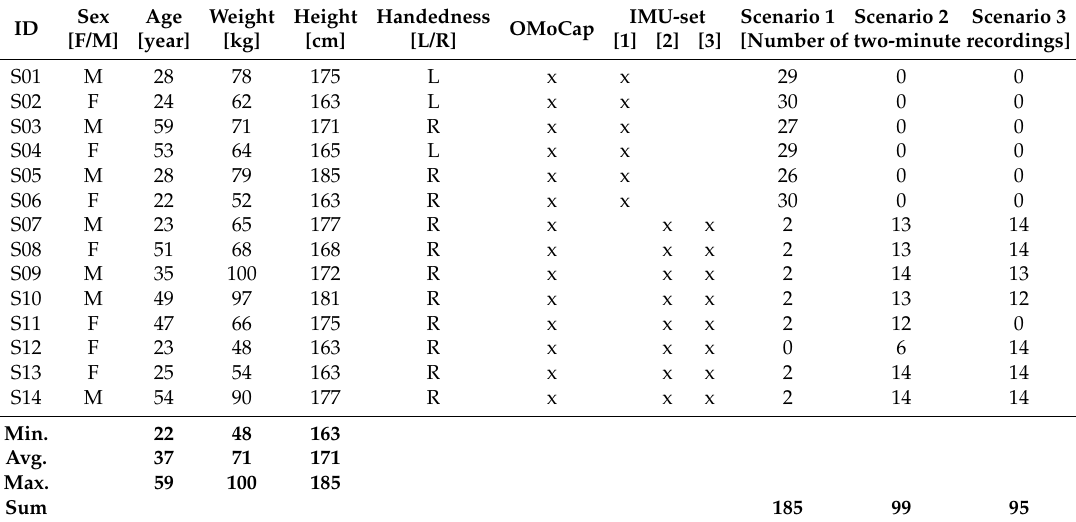
Table 1. Subject: specifications and scenario